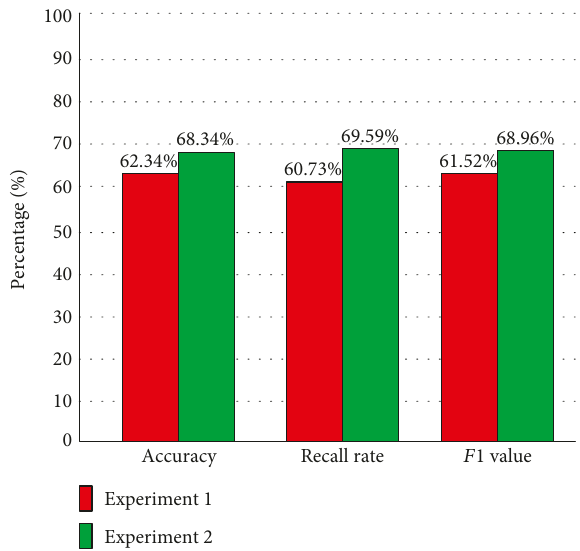
Figure 2: Comparison of Experiment 1 and Experiment 2.